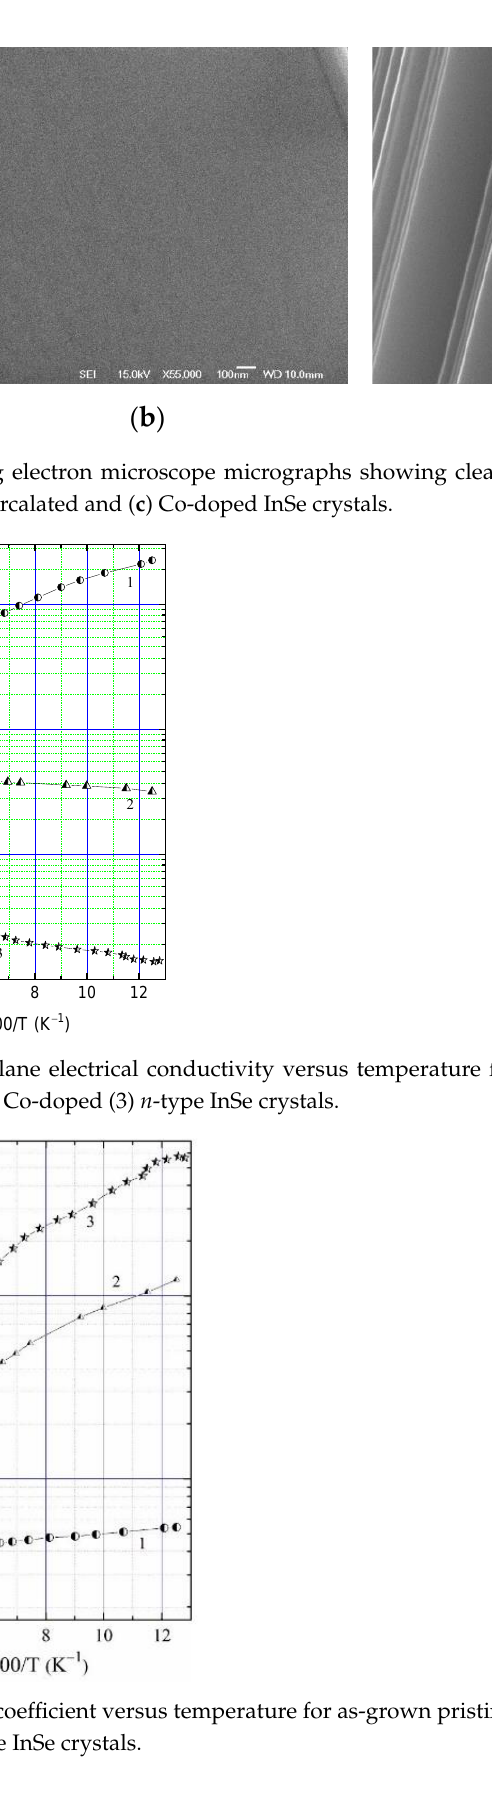
Figure 6. The in-plane mobility versus temperature for as-grown pristine (1), Co-intercalated (2), and Co-doped (3) n -type InSe crystals; calculated curves: 4 – μ FS ( Т ), 5 – μ SCR ( Т ) and 6 – total mobility. 3.3. Electrical Conductivity Anisotropy Physical properties of van der Waals materials are highly anisotropic due to the na- ture of their layered crystal structure [35 – 37]. Thus, in this work we investigated the var- iation of electrical conductivity in different crystallographic directions. For all the samples under investigation the transversal electrical conductivity is significantly lower than the longitudinal one and its variation with temperature exhibit semiconductor behavior (Fig- ure 7, Table 3). In case of the Co-intercalated crystals, the electrical conductivity is lower than for the pristine one and is the lowest for the doped samples. The electrical conduc- tivity anisotropy (ratio of longitudinal and transversal components) is the highest for the pristine n -type InSe and equals ~ 3.3 × 10 3 at T = 80 К ( Figure 8). Meanwhile, it decreases significantly with increasing temperature, namely by a factor of – 270 in the temperature range from T = 80 K to 300 K. The intercalation of cobalt decreases both the anisotropy ratio and the range of its variation in this temperature range. The lowest σ ⊥ С / σ  С values are found for the doped samples, namely, at T = 80 K the conductivity anisotropy decreased by more than a factor of 150 with respect to the pristine sample. It should be noted that to a large degree such low anisotropy values are due to the decrease in the longitudinal com- ponent but not to the increase in the transversal one.